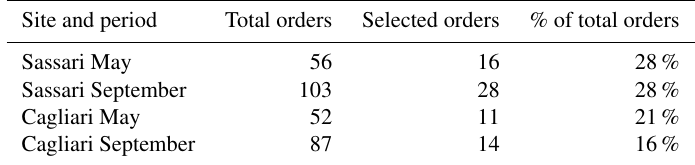
Table 3. Community richness at order level of taxa occurring during dust events and of those displaying variations higher than half the standard deviation between the first 12h and the second 12h sampling period (selected orders). The orders selected upon this criterion as a percentage of the total of the orders observed in samples collected during the dust events is